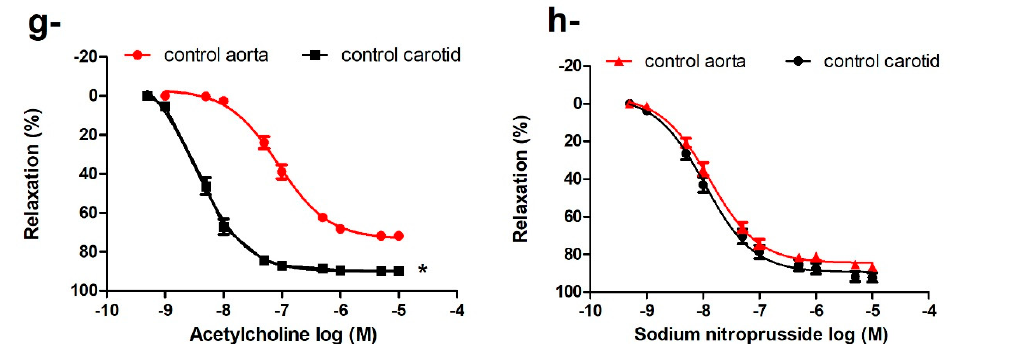
Figure 2. Di ff erential response of the aorta and carotid artery to increased oxidative burden. Cumulative concentration–response curves of acetylcholine in aortae ( a ) and carotid arteries ( b ) in the